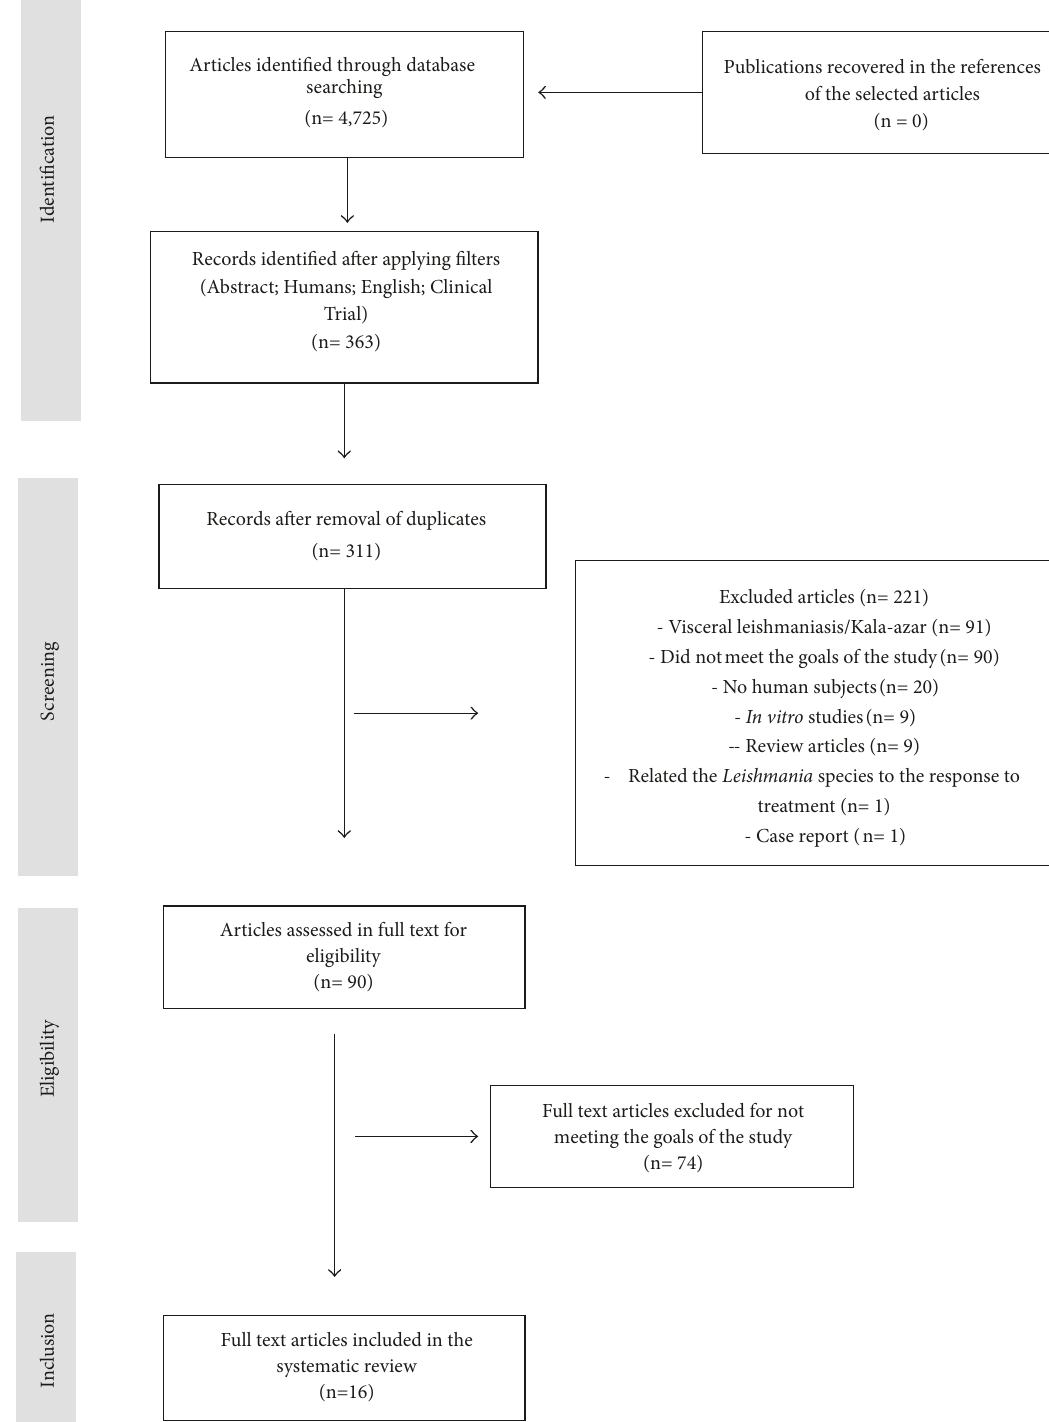
Figure 1: Flow diagram of study selection for the systematic